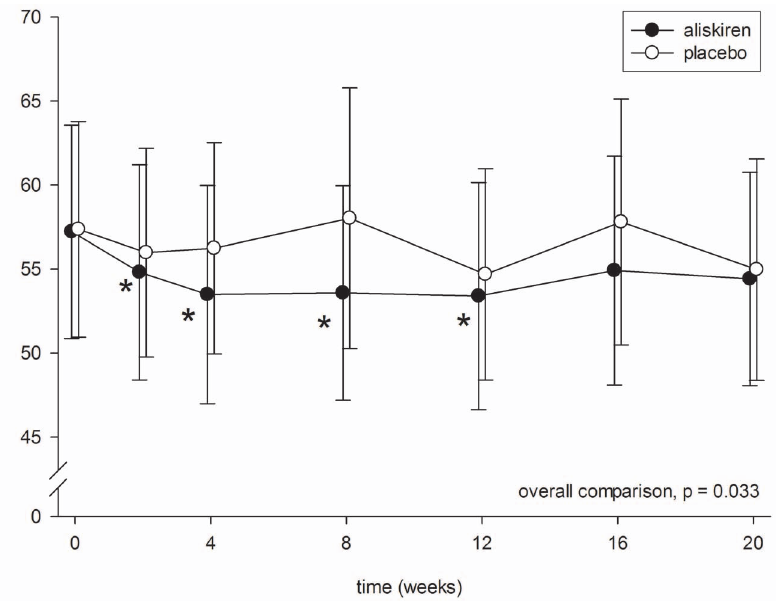
Figure 3. Serial change in estimated glomerular filtration rate (eGFR) during the periods of aliskiren (closed circles) and placebo (open circles) treatment. Error bars denote standard error of mean. Post-hoc comparisons were performed by paired Student’s t test: *p , 0.05 as compared to baseline level. All P values were computed with Bonferroni adjustment for multiple comparisons.